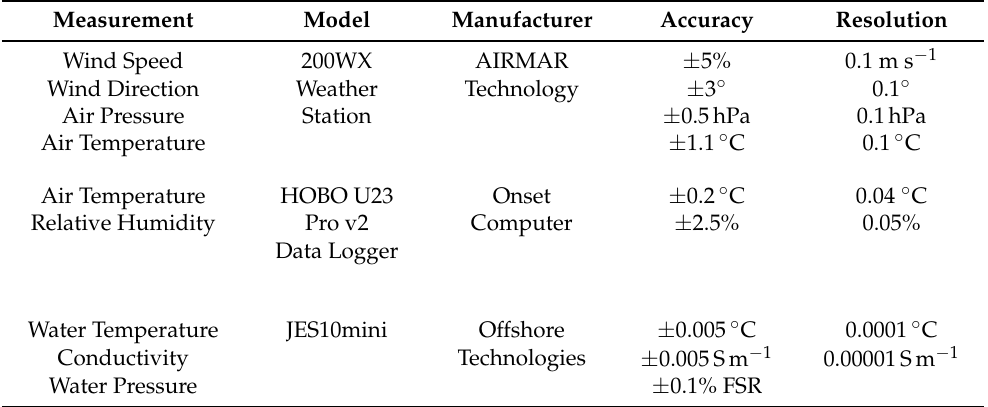
Table 1. Information of meteorological and oceanographic instruments installed to the Wave